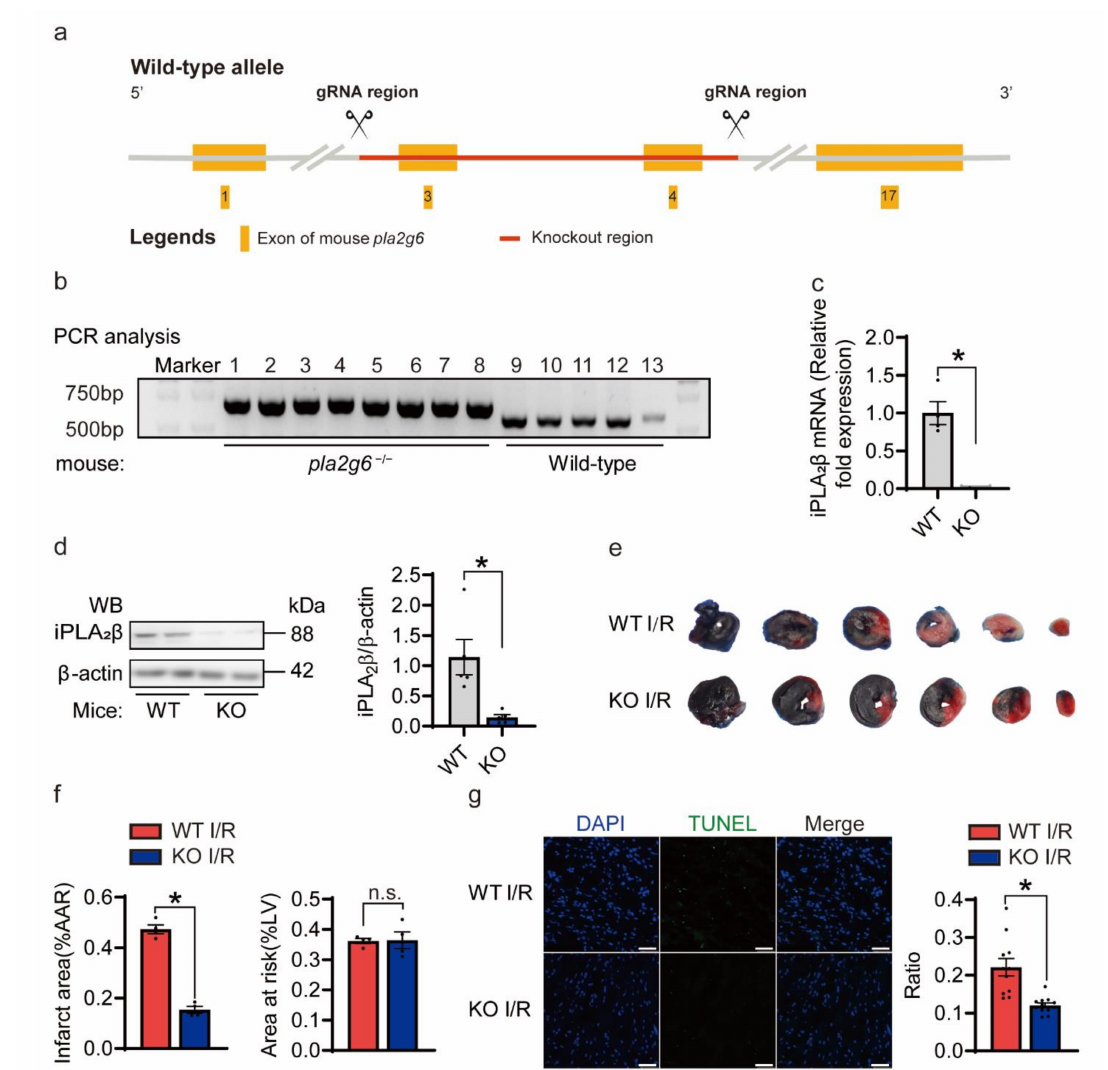
Figure 3. Knockout of iPLA 2 β protects the heart from I/R injury. ( a ) Overview of the targeting strategy to create a Pla2g6 − / − mouse model (C57BL/6N) by CRISPR/Cas9-mediated genome engineering. ( b ) Knockout (KO) mice were genotyped by agarose gel electrophoresis. The size of the PCR product of Pla2g6 − / − mice was 650 bp, whereas the PCR product of the wild-type (WT, Pla2g6 +/+ ) mice was 573 bp. ( c ) Absence of iPLA 2 β mRNA in KO mice. Total RNA was isolated from ventricular tissues of WT and iPLA 2 β KO mice, respectively. Real-time PCR was conducted to assess iPLA 2 β at the mRNA level. n = 4–5 for each group. ( d ) Confirmation of iPLA 2 β deletion in iPLA 2 β -KO mice. Total proteins were extracted from the ventricular tissues of wild-type (WT) and iPLA 2 β -KO mice. Western blotting was conducted to assess iPLA 2 β at protein level. n = 5 for each group. ( e , f ) Knockout of iPLA 2 β protected the heart from I/R injury. WT and iPLA 2 β -KO mice at 12–14 weeks of age were subjected to myocardial ischemia for 30 min, followed by 24 h of reperfusion. Then, 2,3,5-triphenyltetrazolium chloride (TTC) staining was conducted to detect and quantify the injured cardiac tissue. The white region depicts the ischemic infarct zone; the pink/red area is the border zone; and the blue region represents the remote zone. The relative ratio of the infarct region (IF) to the area at risk (AAR, ischemic and border) was compared between WT and iPLA 2 β -KO mice. The relative ratio of AAR to the left ventricle did not differ between WT and KO groups, suggesting that I/R surgery was performed similarly across genotypes. n = 4 per group. ( g ) Representative photographs of heart sections stained with terminal-deoxynucleotidyl transferase-mediated dUTP nick end labeling (TUNEL) from WT and KO mice after myocardial I/R (left). Scale bar = 25 µ m. Quantification is shown on the right. n = 10–11 per group. Data are represented as mean ± SEM. All experiments were independently replicated in triplicate. * p <